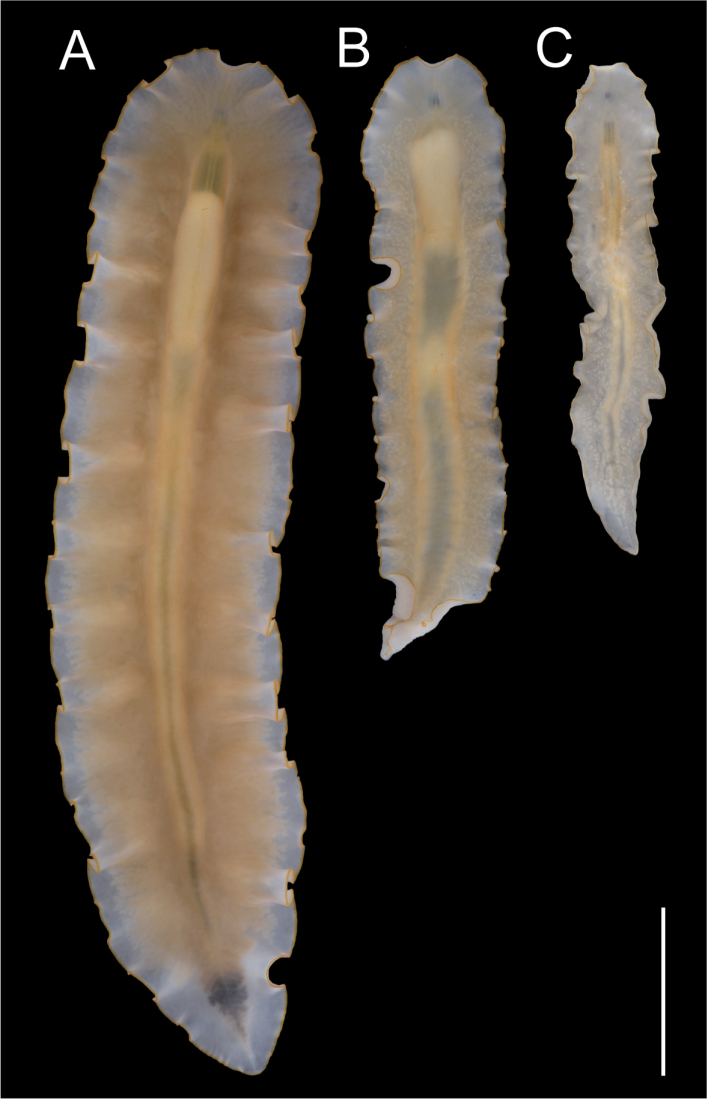
Difference in mature body size among Enchiridium
daidai sp. nov. AICHUM 5993 (holotype), from Kagoshima BICHUM 5995 (paratype), from Okinawa CICHUM 5994 (paratype), from Okinawa. Scale bar: 10 mm.